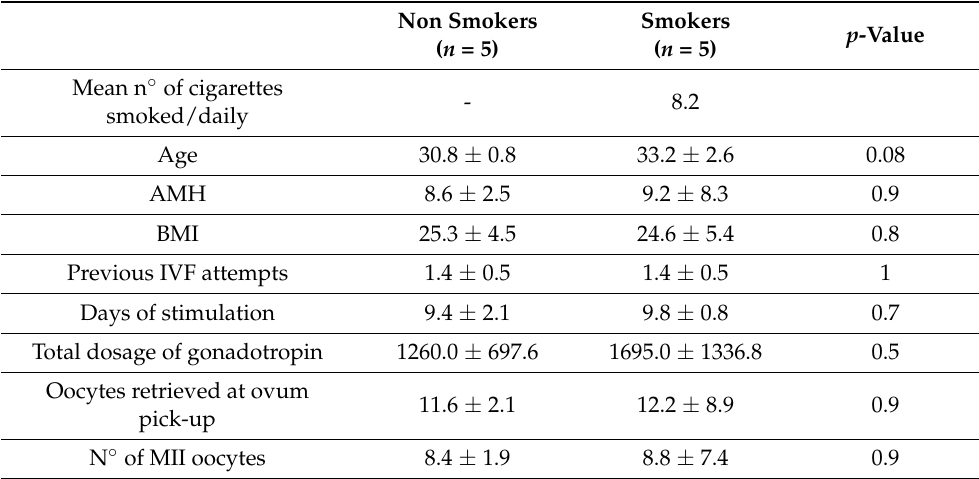
Table 1. Patients’ demographic